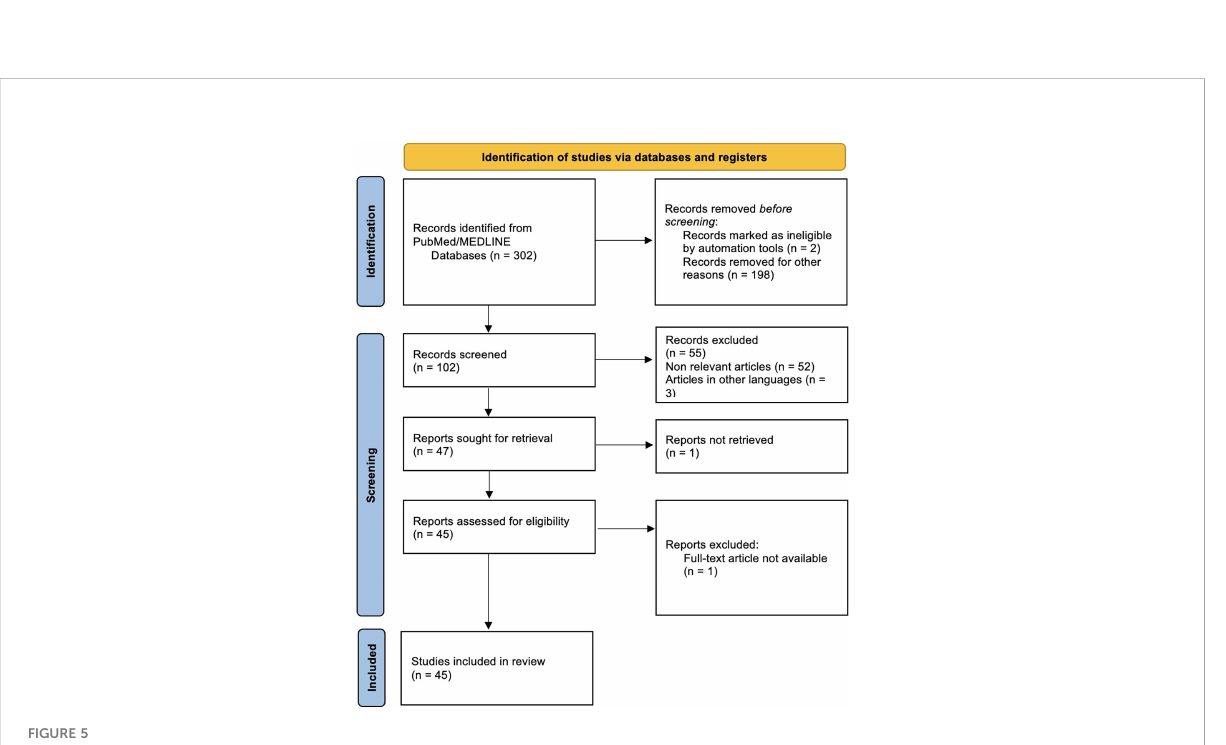
FIGURE 5 .PRISMA fl ow